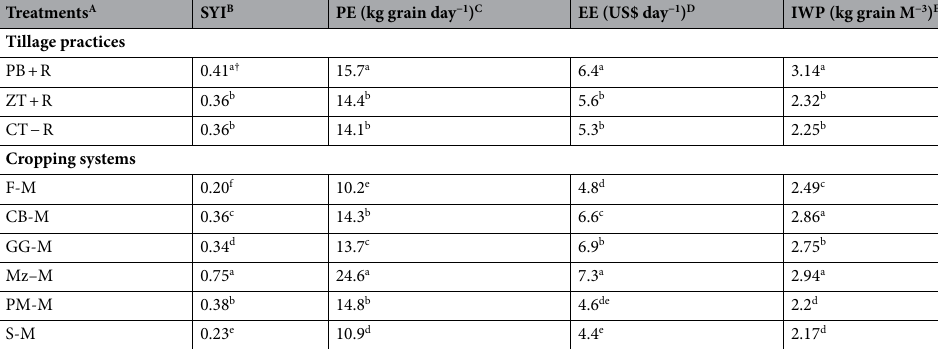
Treatments A SYI